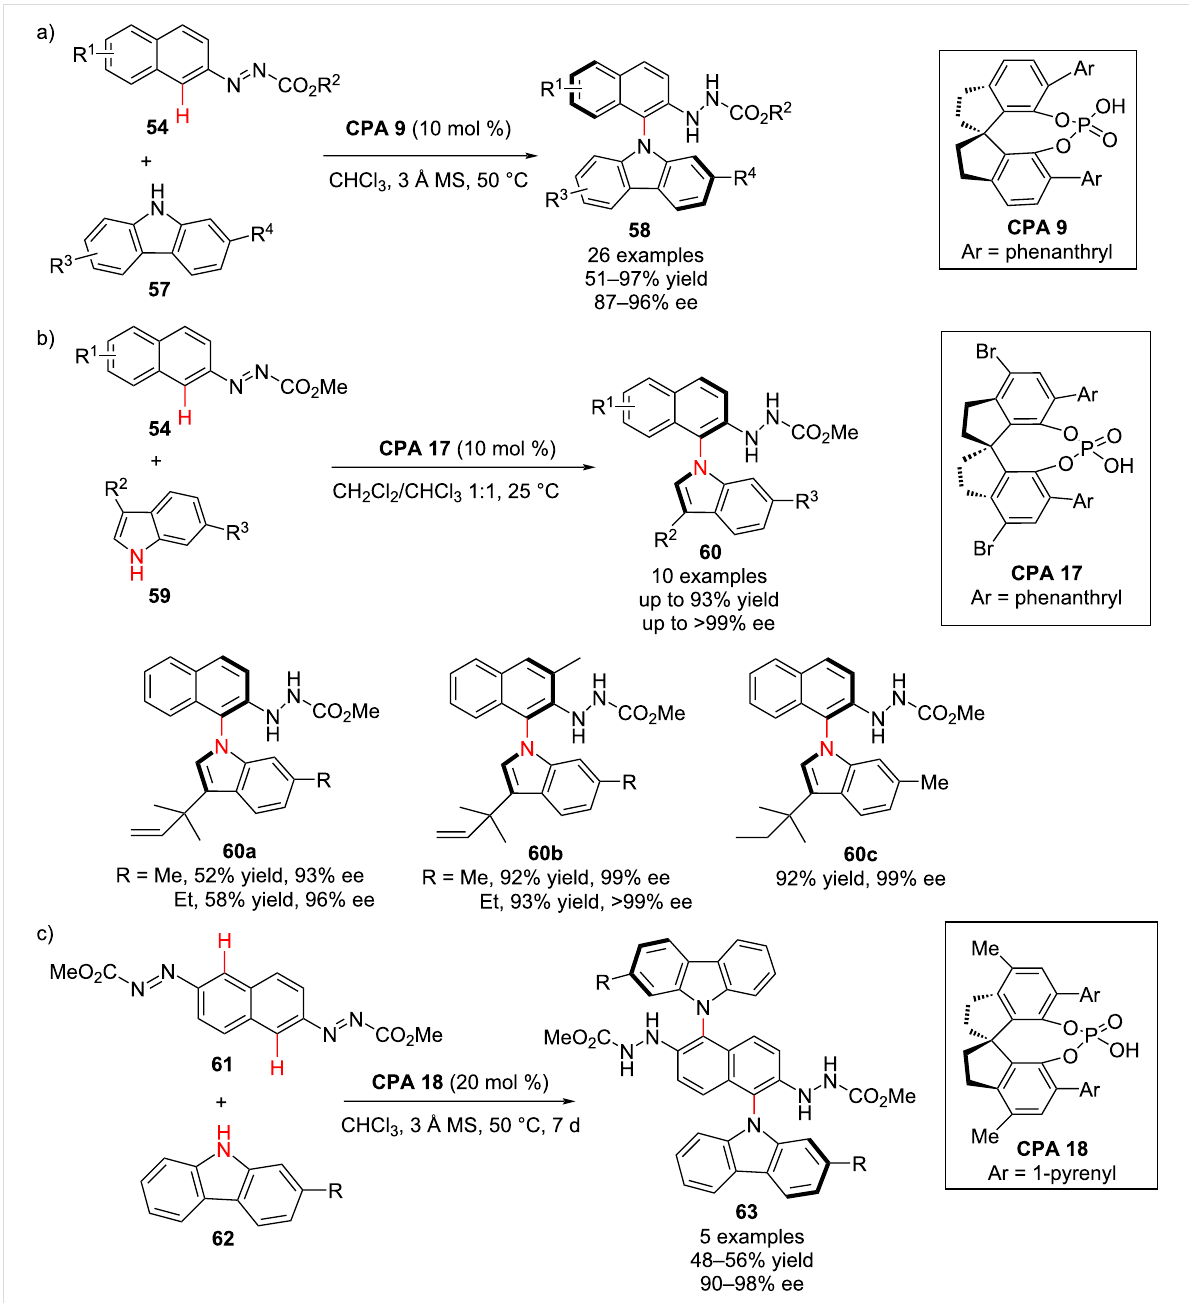
Scheme 20: Enantioselective and atroposelective synthesis of axially chiral N -arylcarbazoles